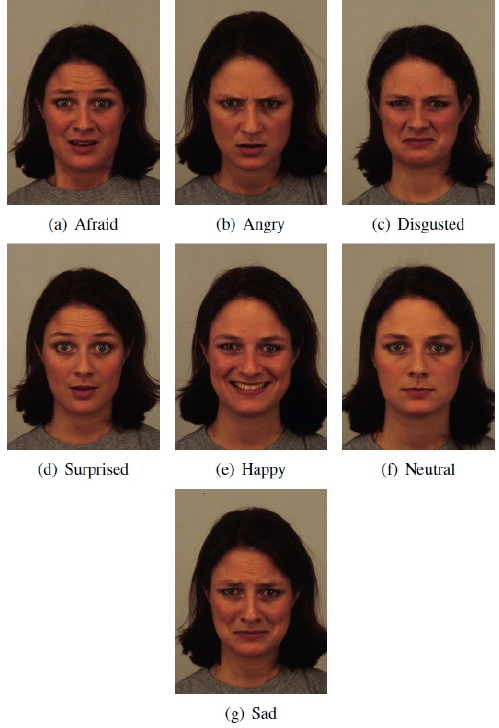
Figure 2. Karolinska Directed Emotional Faces database images